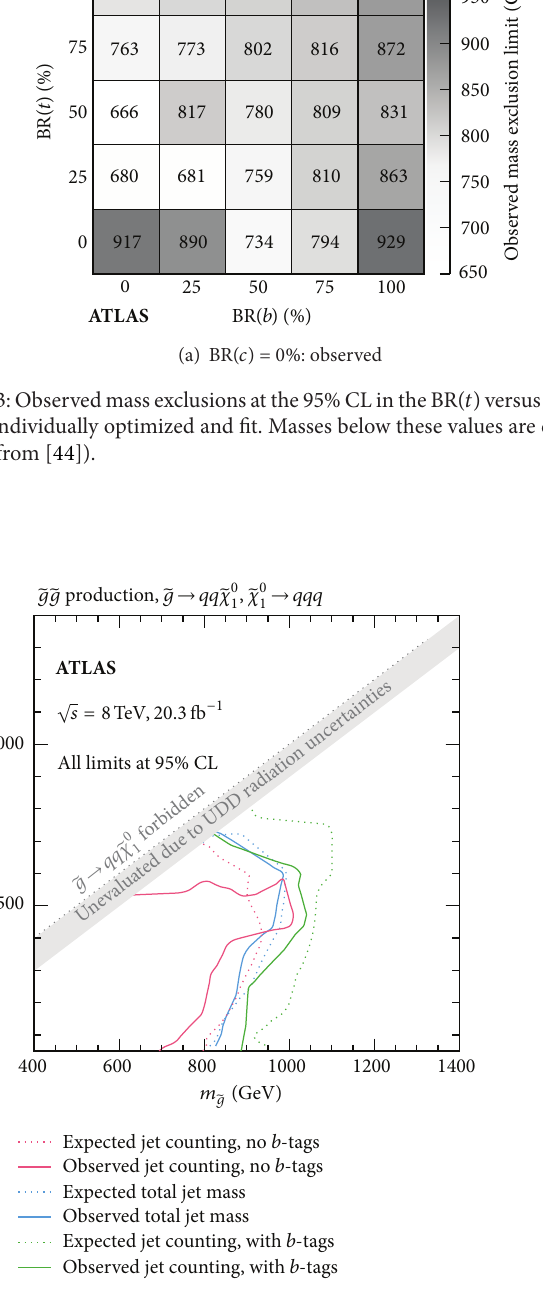
Figure 14: Expected and observed exclusion limits in the ( 𝑚 ̃𝑔 −𝑚 ̃𝜒 0 planefortheten-quarkmodelforthejet-countinganalysis(withand without 𝑏 -tagged jets) and the total-jet-mass analysis (from [44]).